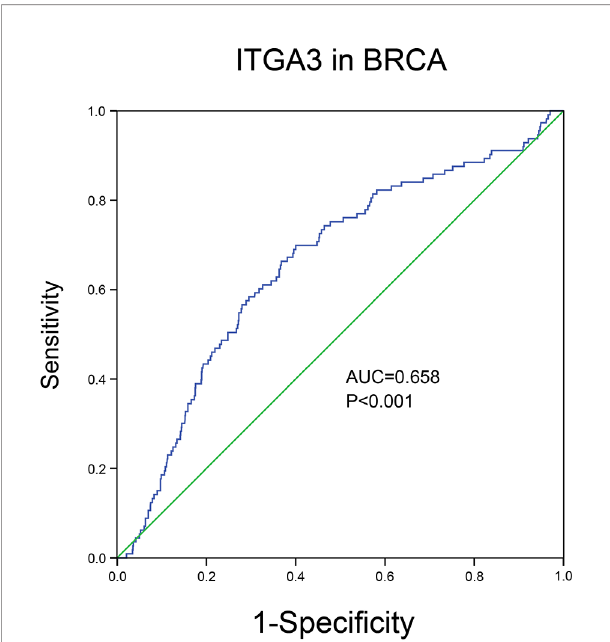
FIGURE 5 | The diagnostic value of ITGA3 in BRCA based on the TCGA data. P-value <0.05 was considered as statistically signi fi